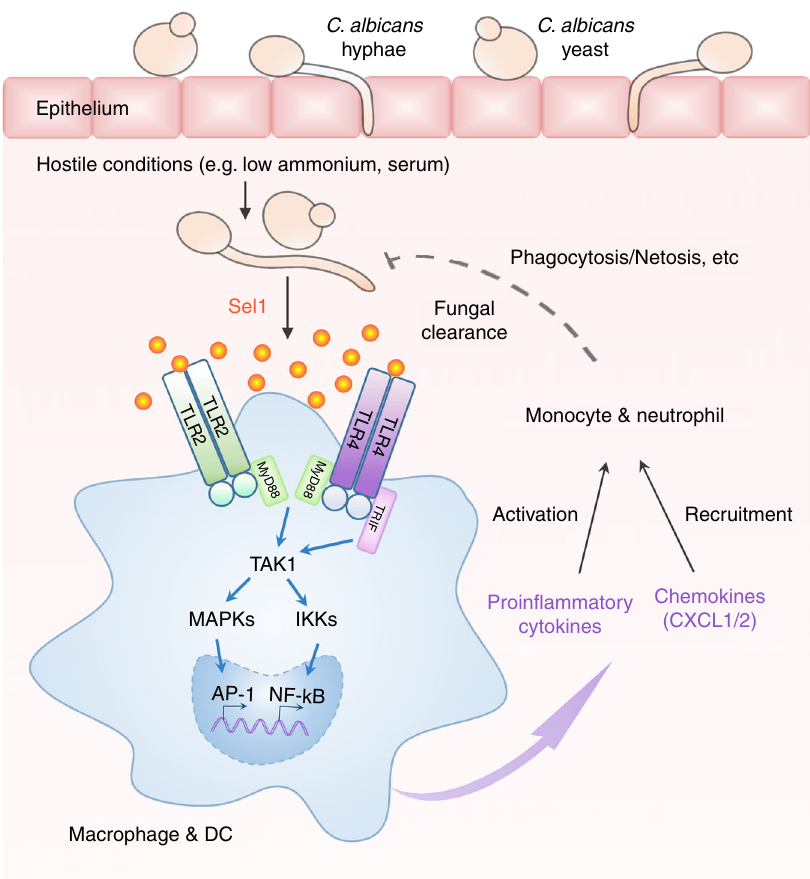
Fig. 6 Sel1 represents a novel fungus-derived PAMP for host immune response. Upon invasive infection, C . albicans encounter the hostile conditions, such as low ammonium and rich serum, which are widely present in the bloodstream and various tissue environments, therefore elevating Sel1 expression/ secretion accordingly. Following its secretion, Sel1 can be sensed by both Toll-like receptors 2 and 4 (TLR2 and TLR4), which are abundantly expressed in macrophages and dendritic cells (DCs), leading to the activation of IKK/NF- κ B and MAPK/AP-1 (mitogen-activated protein kinase/activator protein 1) pathways, triggering the production of cytokines such as tumor necrosis factor (TNF), interleukin (IL)-6, and IL-1, and chemokines CXCL1 and CXCL2 (chemokine (C-X-C motif) ligands 1 and 2) to recruit and activate neutrophils and monocytes for fungal